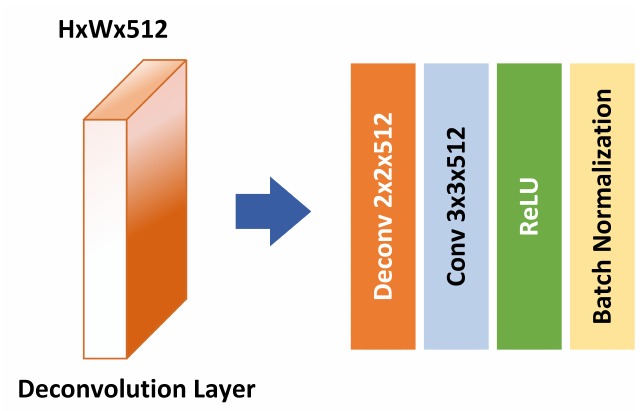
Figure 5. A deconvolutional module unit used after the SSD layers.